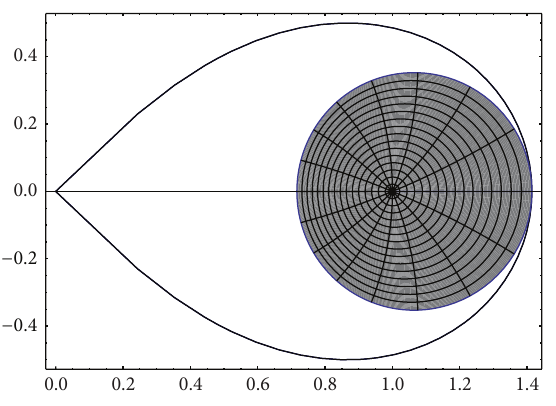
Figure 2: Image of |𝑧| ≤ 0.1129 touches |𝑤 2 − 1| = 1